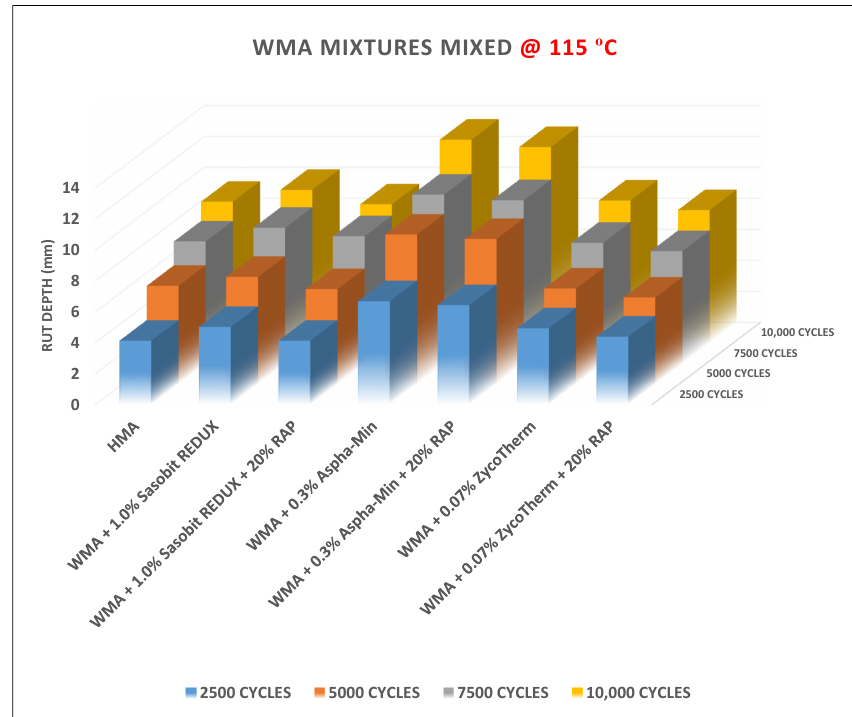
Figure 24. Rutting depth for the modified virgin and recycled WMA mixtures mixed @ 115 °C.